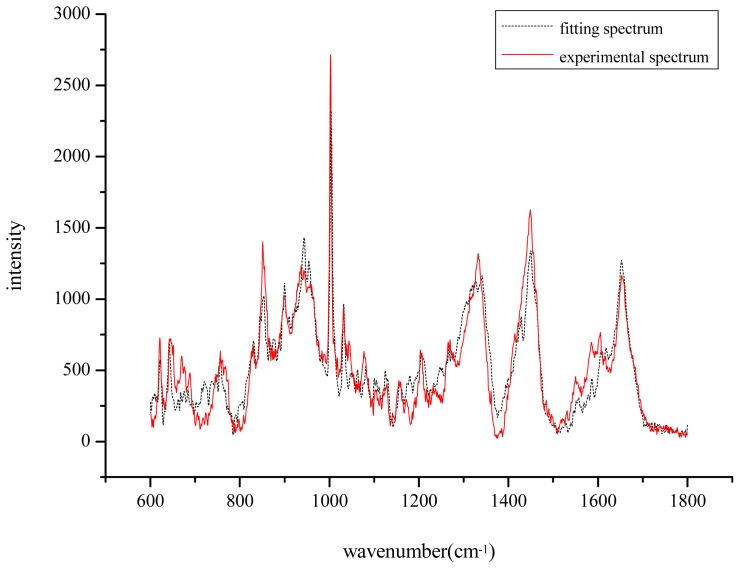
The average spectrum of the samples(
) and the fitting spectrum(…).